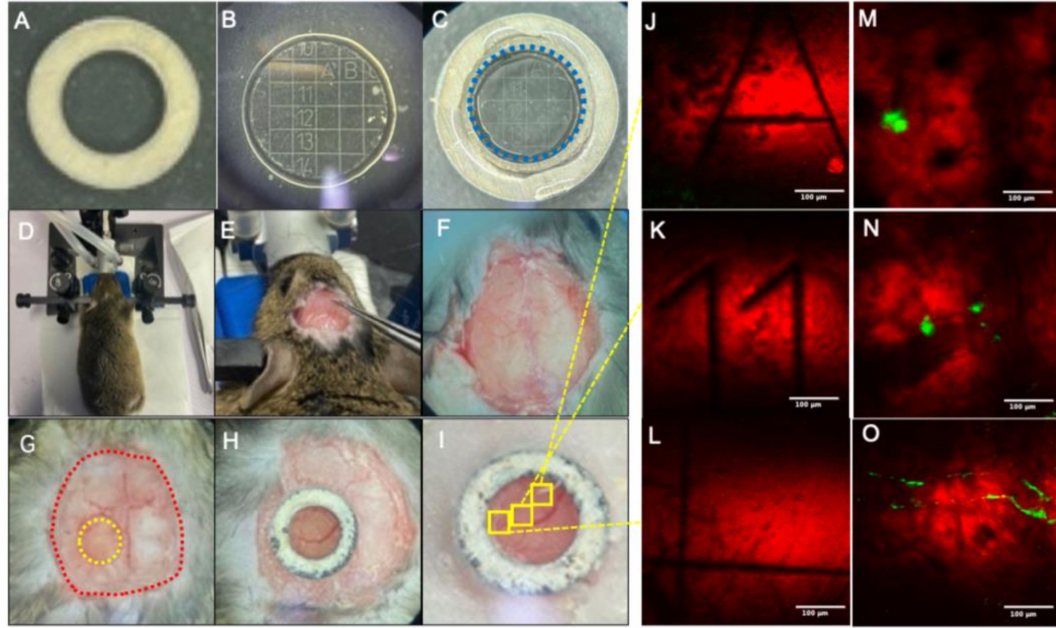
Figure 1. Fabrication and placement process of cranial window: ( A ) Customized hollow titanium ring. ( B ) Customized cranial window glass. ( C ) Cranial window assemblies bonded with optical glue; the blue dotted line represents the glass outline. ( D ) Head immobilization. ( E ) Fascia removal. ( F ) Preliminary processing completed. ( G ) Craniotomy, the yellow dotted line indicates the craniotomy area and the red dotted line indicates the exposed area of the skull. ( H ) Installation of cranial windows. ( I ) Bonding cranial window. ( J – L ) Coherent anti-Stokes Raman scattering (CARS) imaging of cranial window glass. ( M – O ) Mouse brain imaging of the corresponding position of cranial window glass. Scale bar: 100 µ